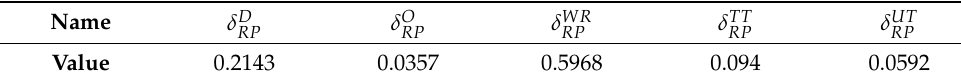
Table 17. Final estimated importance weights of AHP of recovery